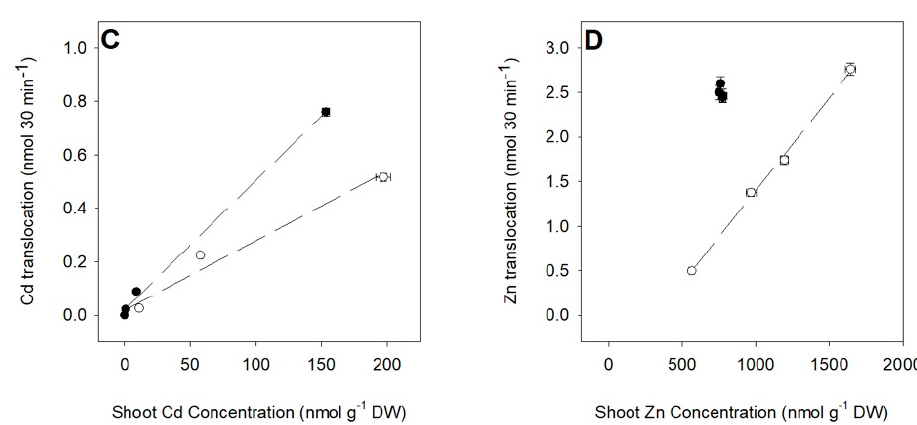
Figure 5. Cd and Zn xylem loading under Cd exposure. Capataz (white circles) and Beirao (black circles) were exposed to different Cd concentrations (0.01, 0.1, and 1 μ M) for 10 days. At the end of the exposure period, shoots were separated from roots and the xylem sap exuded from the cut (root side) surface was collected over a 30 min period. Cd ions loaded and transported in the xylem sap ( A ). Zn ions loaded and transported in the xylem sap ( B ). Relationship between Cd ions loaded in the xylem sap and Cd concentration in shoots ( C ). Relationship between Zn ions loaded in the xylem sap and Zn concentration in shoots ( D ). Data are means and SE of two experiments run in triplicate (n = 6). DW, dry weight.